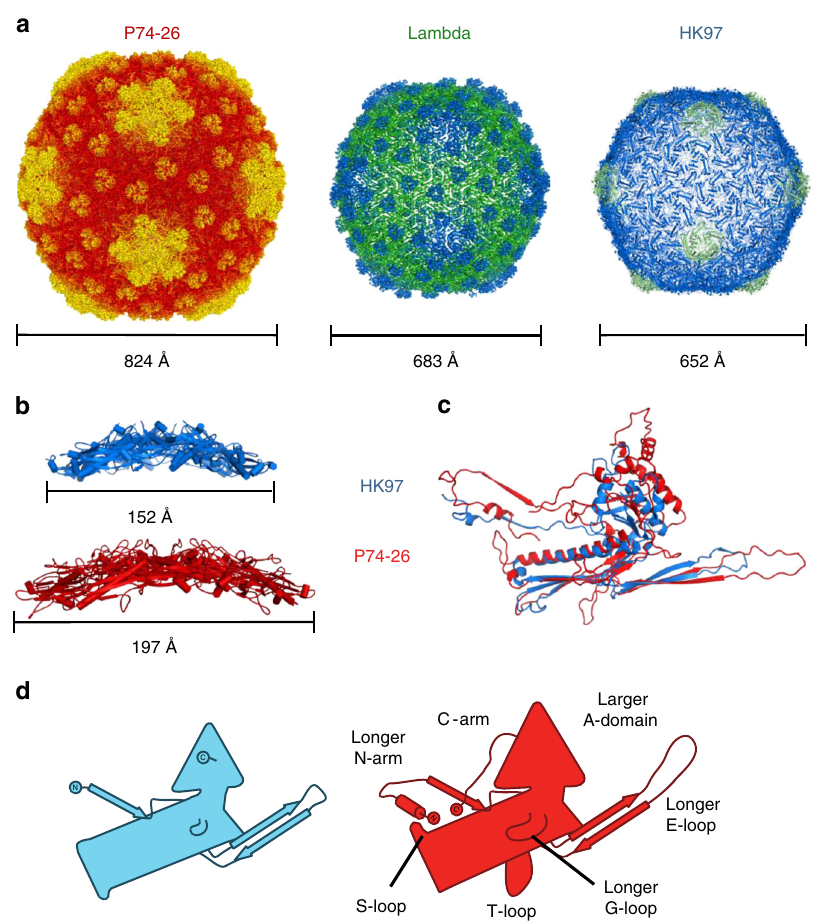
Fig. 4 P74-26 has signi fi cantly increased capsid capacity compared to T = 7 mesophilic viruses. a Size comparison of P74-26 and homologous mesophilic T = 7 phages Lambda and HK97. Corresponding capsid diameters (longest outer diameter measured from fi vefold axes) are listed below each structure. b Size comparison of hexons from HK97 (blue) and P74-26 (red); longest hexon diameters are listed below each structure. c Overlay of HK97 and P74-26 MCP, aligned on the HK97 fold P-domain. d Schematic representations of MCP from HK97 (left, blue) and P74-26 (right, red). Labels indicate features unique to P74-26